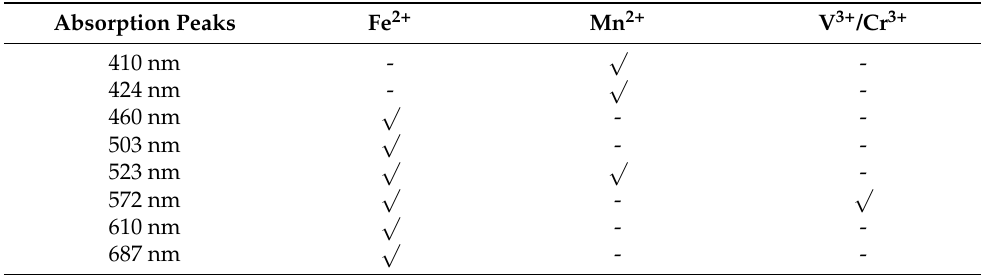
Table 3. Assignment of absorption maxima observed in pyrope-almandine. The assignment of the bands is signed by tick.